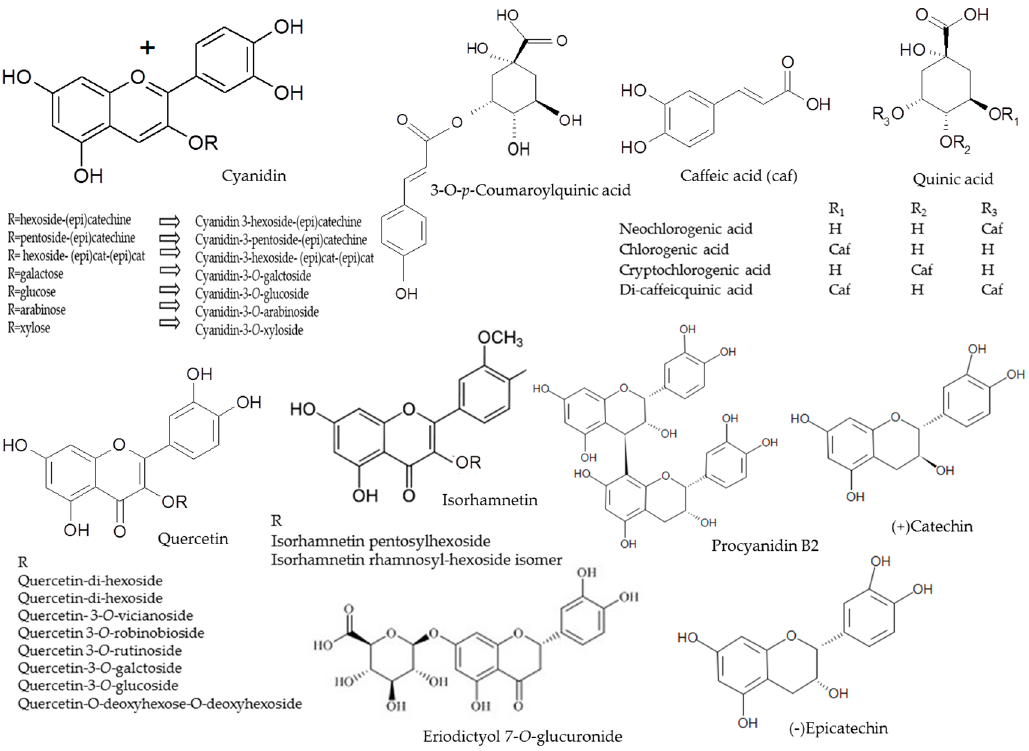
Figure 5. Chemical structures of polyphenolic compounds present in chokeberries. Molecules 2017 , 22 , 1161